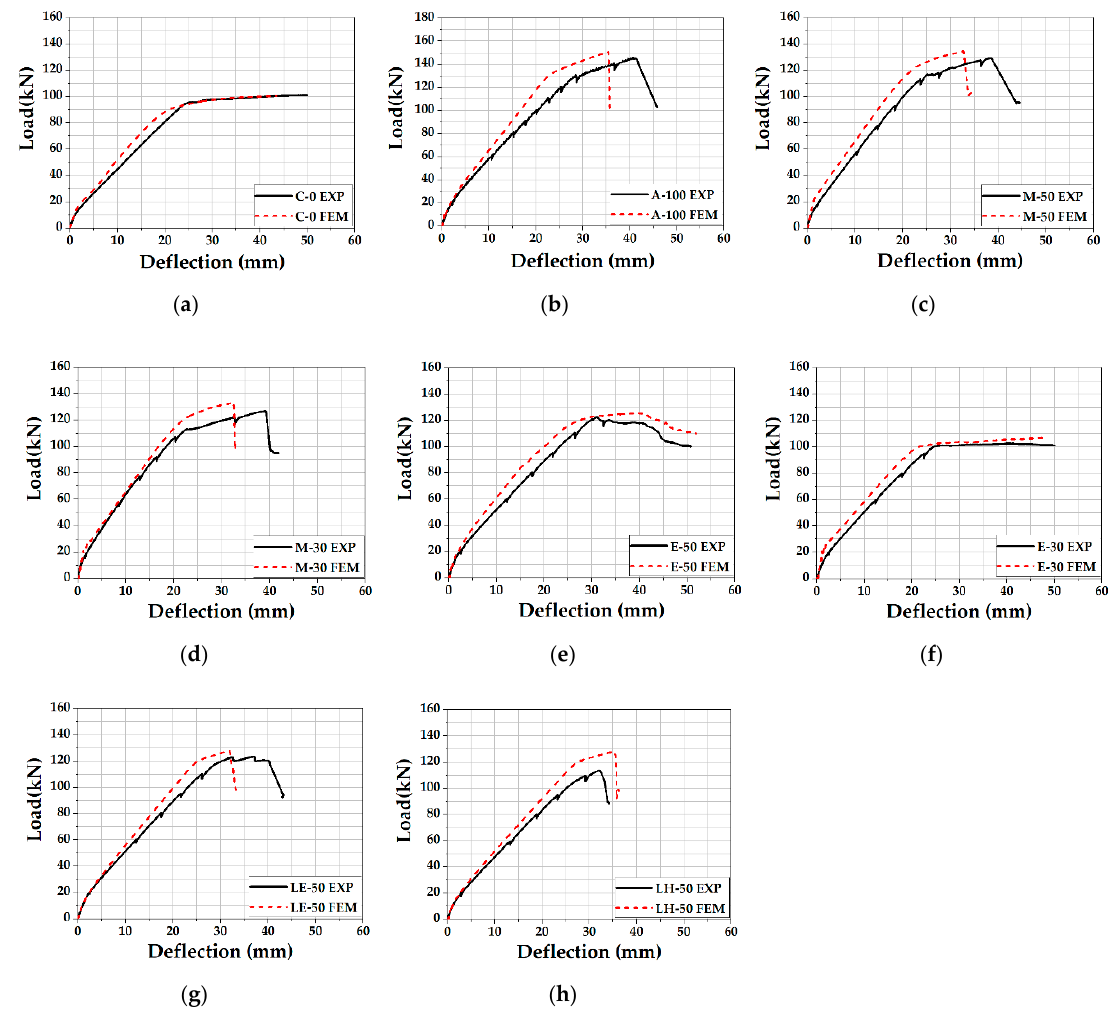
Figure 7. Comparison of load-deflection curves between experiment and analysis. ( a ) C-0, ( b ) A-100, ( c ) M-50, ( d ) M-30, ( e ) E-50, ( f ) E-30, ( g ) LE-50, and ( h ) LH-50.